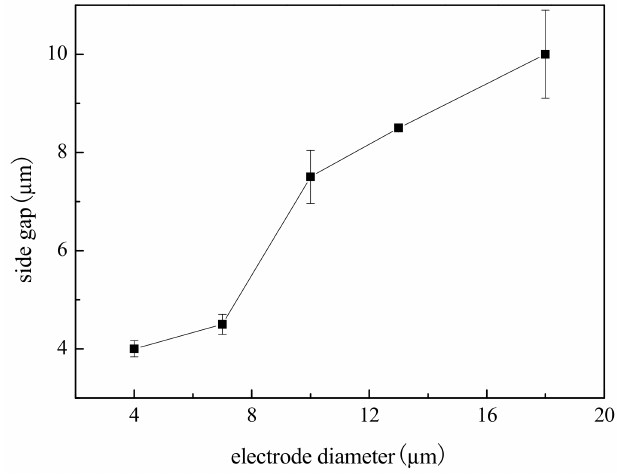
Figure 13. Effect of electrode diameter on side